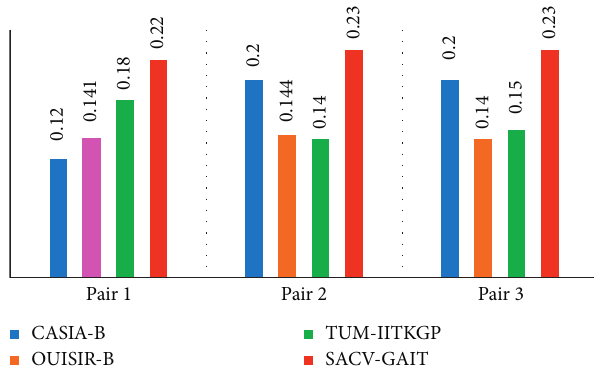
Figure 17: SD of CCS observed in pair 1, pair 2, and pair